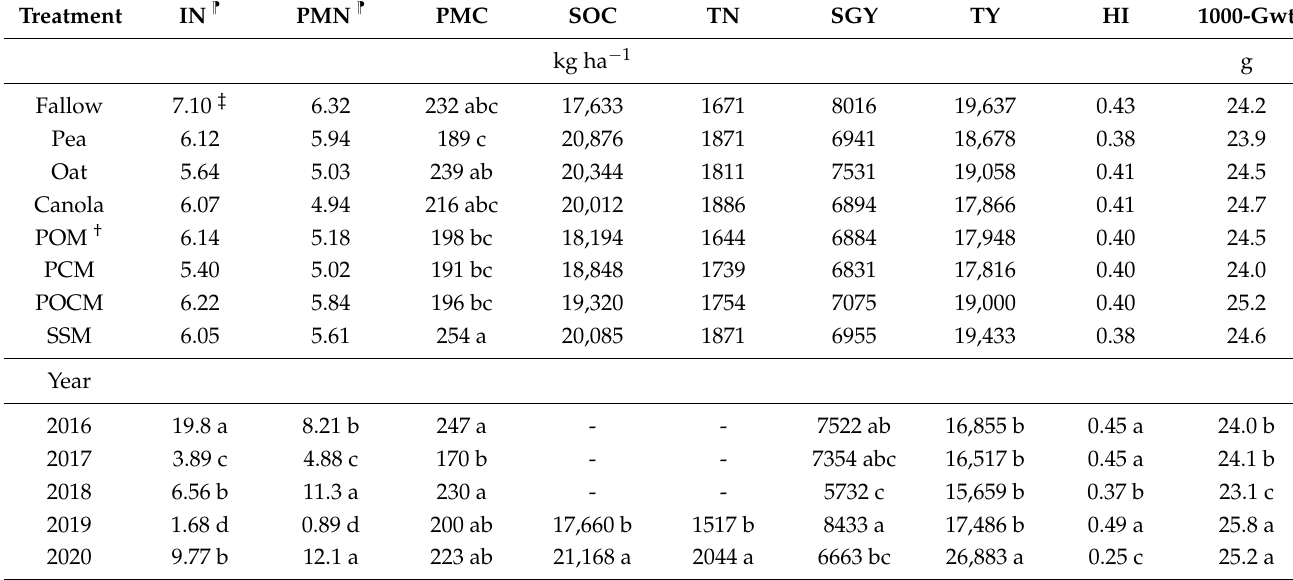
Table 3. Means of treatment and year on soil inorganic nitrogen (IN), potentially mineralizable nitrogen (PMN) and carbon (PMC), soil organic carbon (SOC), total N (TN), sorghum grain yield (SGY), total yield (TY), harvest index (HI), and thousand-grain weight (1000-Gwt).